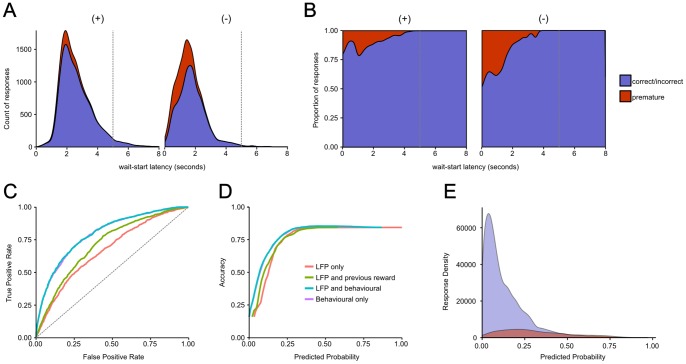
Predicting upcoming impulsive responses.A) Stacked distribution of premature and non-premature (i.e. correct and incorrect) responses as a function of latency of rats to move to wait-start, divided into trials where the previous trials was rewarded (+), or non-rewarded (−). Time zero is the start of the trial, a vertical grey line represents the time of stimulus light presentation (or in the case of premature responses, the time the stimulus light would have been presented). B) Distribution of premature and non-premature responses as depicted in A, represented as a proportion of all responses. C) Receiver-operator characteristic curve for models predicting upcoming premature responses based on leave-one-out cross-validation results. The diagonal grey line represents an uninformative classifier. D) Plot of model accuracy ([number of true positives] + [number of true negatives]/[number of true positives] + [number of false positives] + [number of true negatives] + [number of false negatives]) against threshold predicted probability value. E) Distribution of predicted probabilities for true premature and non-premature trials from the full (behaviour plus LFP) model. The area under each curve is equal to the total number of trials.